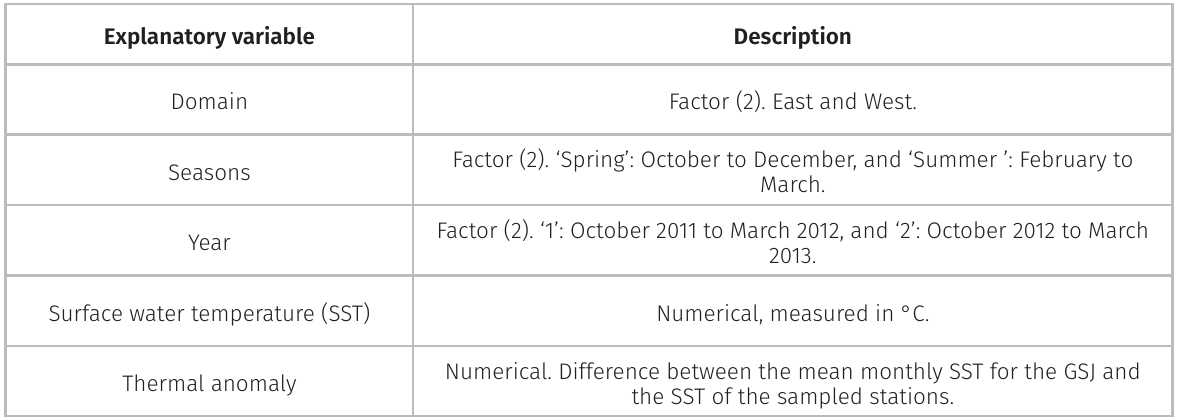
Table I. Explanatory variables tested in the PERMANOVA analysis. The numbers in parentheses indicate the number of levels in each factor. SJG: San José